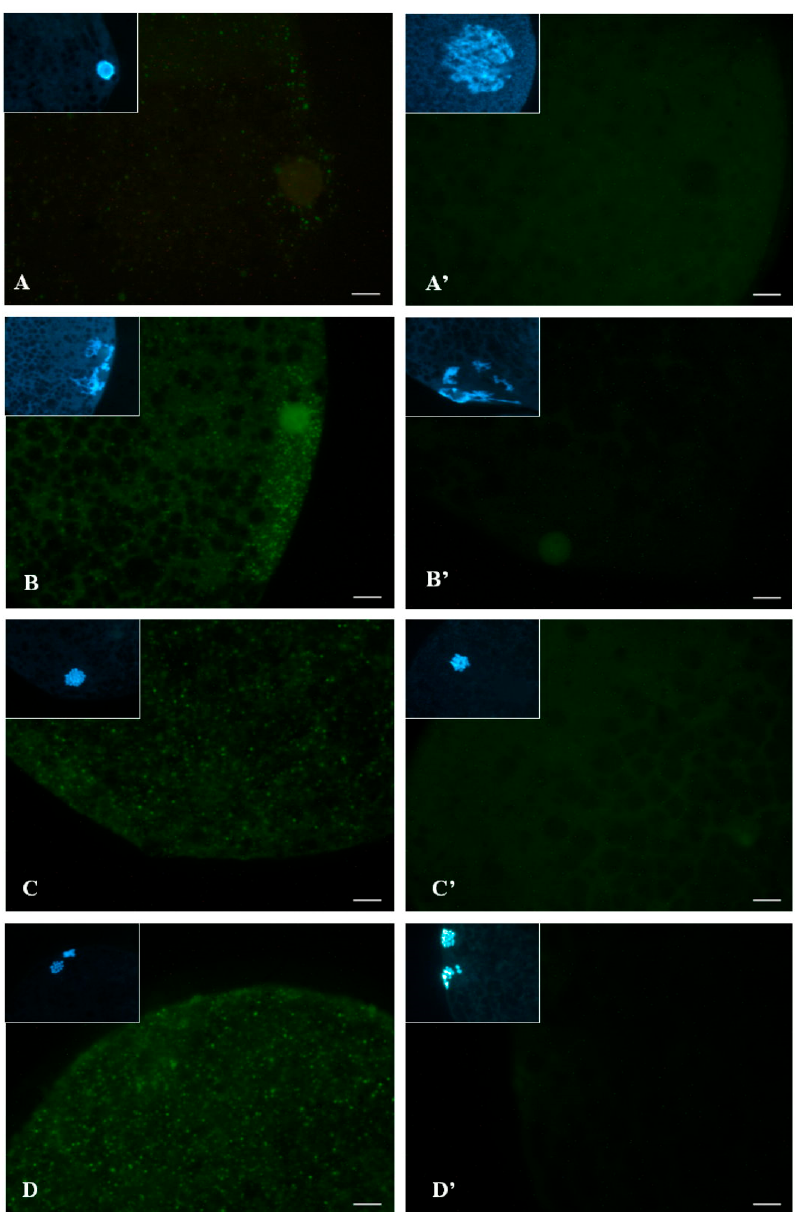
Figure 4. Subcellular localization of phosphorylated p38 (p-p38) in porcine oocytes during IVM. ( A ) Phosphorylated p38 was initially visible as a few green dots in the ooplasm at the GV stage prior to IVM culture (0 h). ( B ) p-p38 was somewhat more concentrated in or around the GV nucleus at GVBD 18 h after IVM. At the MI ( C ) and MII ( D ) stages, p-p38 was localized to the ooplasm surrounding chromosomes. A’ to D’ are the negative controls. Insets show chromatin or chromosomes (blue) stained with Hoechst 33342. Scale bar, 10 μ m.